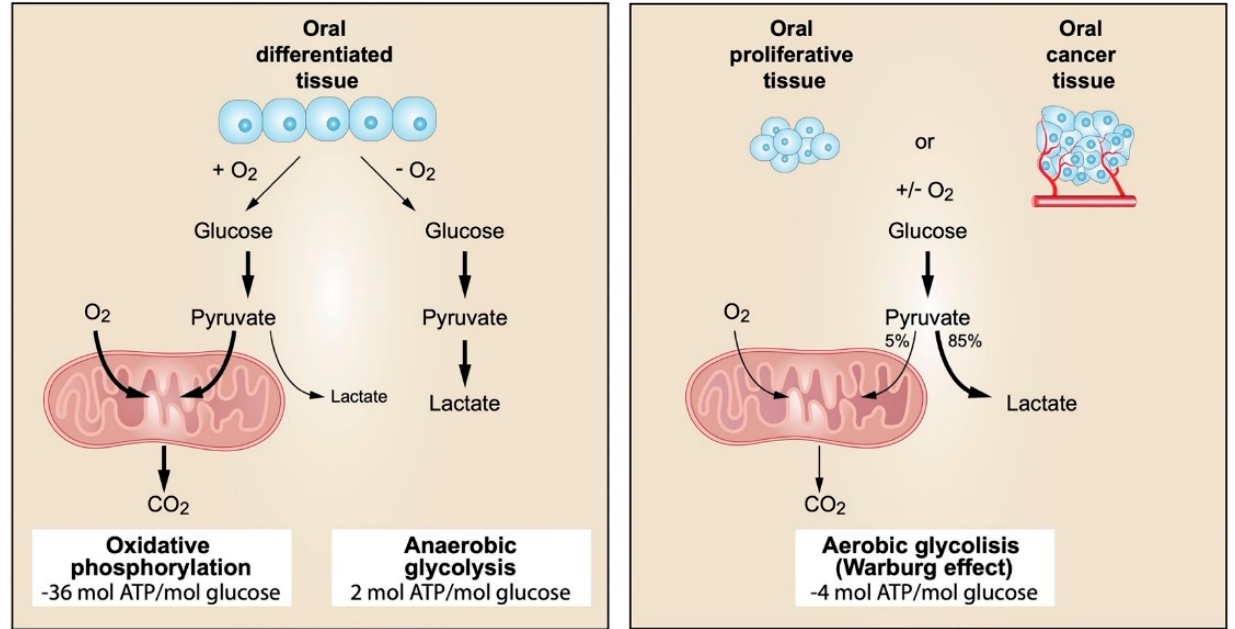
Figure 4. Graphic representation of the reprogramming energetic metabolism in oral squamous cell carcinomas, modified from Vander Heiden et al. [239]. Energetic metabolism in mammalian cells depends essentially, but not exclusively, on the consumption of glucose. The type of energy metabolism adapted by cells is primarily influenced by the availability of oxygen in the surrounding environment and by their proliferative state. Quiescent cells from oral differentiated tissues, in the presence of oxygen, adopt a type of metabolism called oxidative phosphorylation, converting glucose through glycolysis into pyruvate, which is subsequently converted into CO 2 in the mitochondria through the tricarboxylic acid cycle (TCA). In this process, the cofactor NADH (nicotinamide adenine dinucleotide reduced) is produced, which is relevant for maximising energy production in the form of ATP (adenosine 5’-triphosphate). During oxidative phosphorylation, a small amount of glucose is metabolised to lactate production. The net result of this energy programme is the production of 32 molecules of ATP for each molecule of glucose. In hypoxic situations, quiescent cells develop a type of metabolism known as anaerobic glycolysis, which shifts glucose metabolism towards lactate production, resulting in a much lower energy yield compared to oxidative phosphorylation, resulting in 2 molecules of ATP for each molecule of glucose metabolised. On the other hand, oral proliferative tissues and oral cancer cells develop an apparently paradoxical type of metabolism, called aerobic glycolysis (also known as the Warburg effect), whereby, even in the presence of oxygen, most of the glucose (85%) is derived to produce lactate, while a small percentage (5%) is metabolised in the mitochondria to produce CO 2 and a small amount of ATP—4 molecules of ATP for each molecule of glucose.